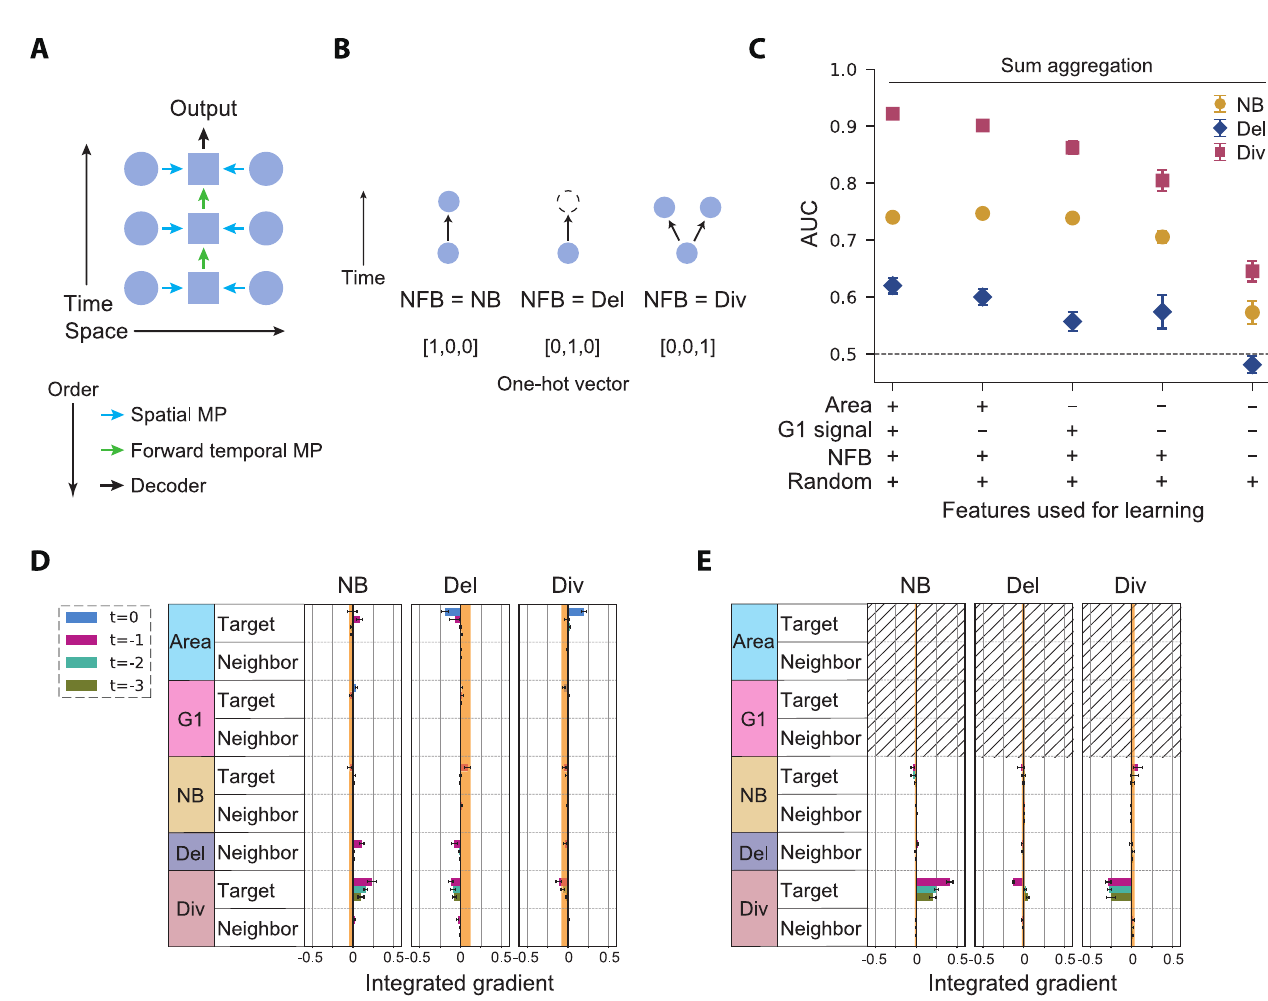
Fig 2. Unidirectional spatiotemporal GNN model with sum aggregation. (A) The next frame behavior (NFB) feature introduced to represent the local branch structure. (B) Schematic of the information flow in the model of the unidirectional spatiotemporal GNN (see Fig 1D). (C) The AUC of the unidirectional spatiotemporal GNN is shown for models under various feature sets, obtained by averaging over six trained models. Error bar: standard deviation. (D and E) The attributions of the unidirectional spatiotemporal GNN model are shown for each feature condition: (Area, G1-phase signal, NFB, Random) = (+, +, +, +) (D) and ( − , − , +, +) (E). The integrated gradients (IG) averaged over six trained models is shown for each pooled feature. Positive and negative IGs represent the positive and negative effects of the features (rows) on the fates (columns), respectively. Error bar: standard error. The upper and lower values of the IGs of the random features are shown as the orange zone as an indicator of the baseline IG level.